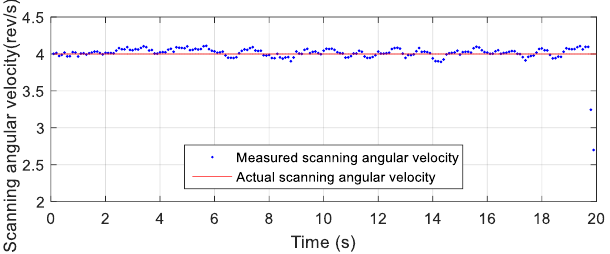
Figure 6. Scanning angle of the simulation based on the geomagnetic field.